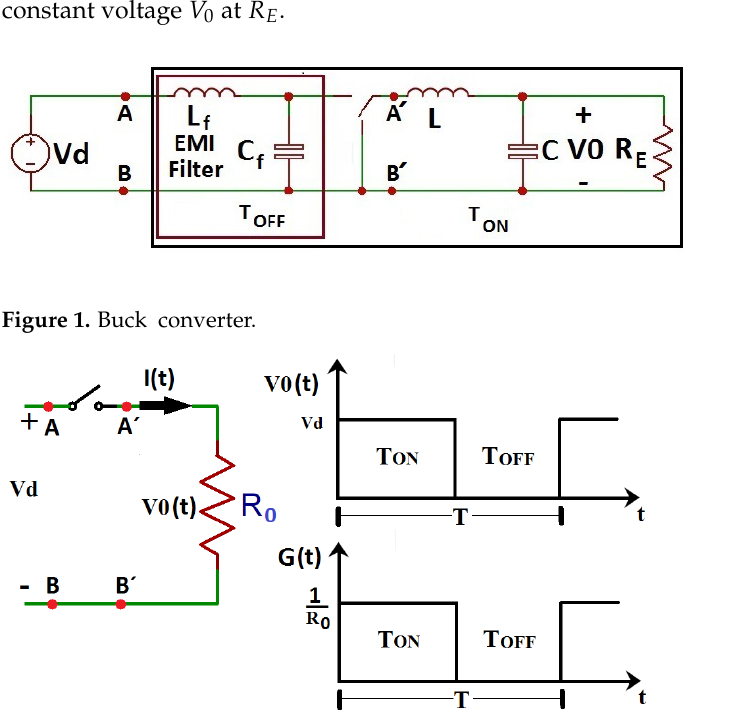
Figure 2. Switching circuit.